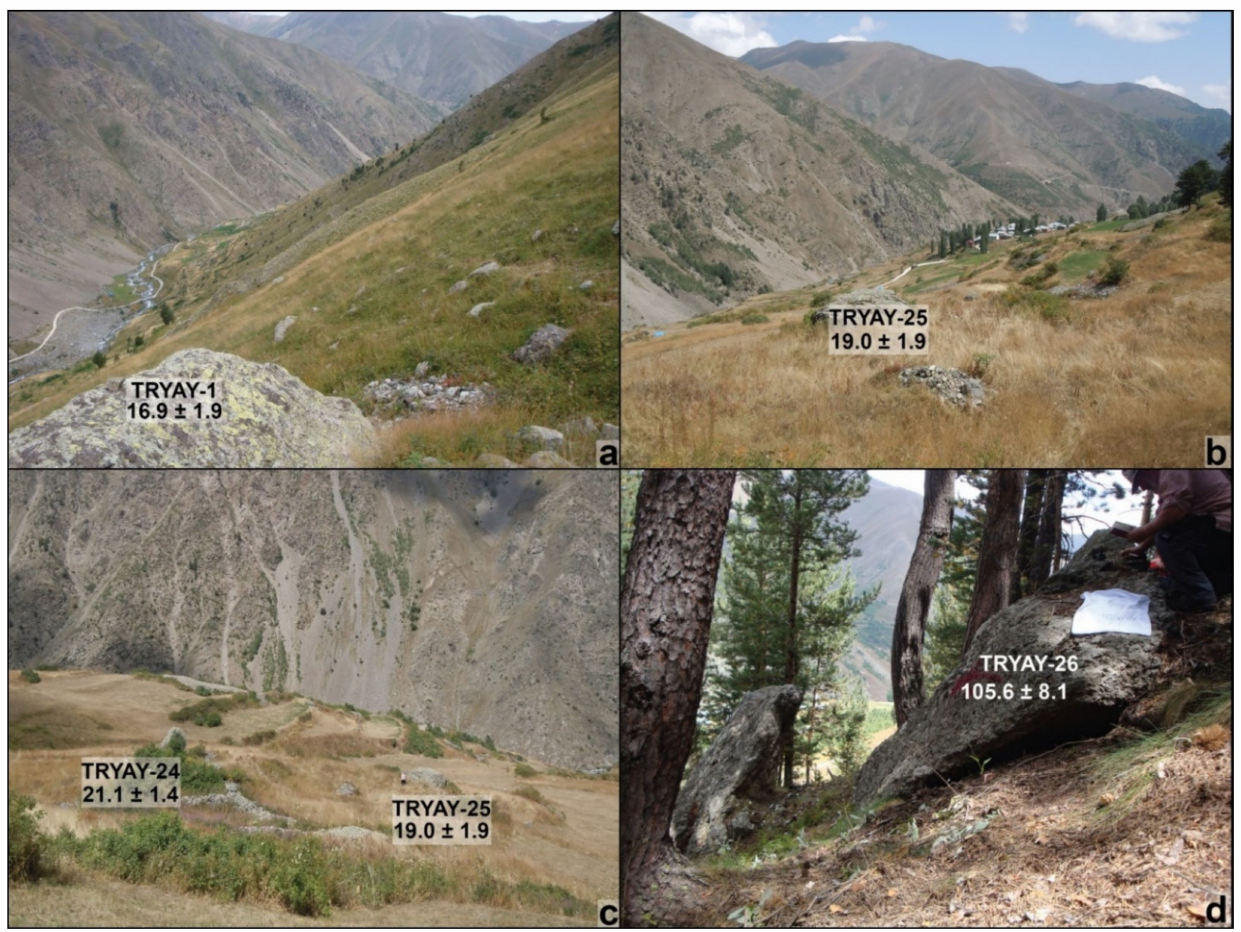
Figure 7. ( a ) Down-valley view from sample station TRYAY-1 at the upper glacier margin. Note the difference in slope morphology with ice contact to the right and superficially decomposing bedrock to the left (see also Figure 7b,c). ( b , c ) Middle part of Barhal Valley with sampled boulders TRYAY-24 (22.2 ± 2.6 ka advance) and TRYAY-25 (18.3 ± 1.7 ka advance). ( d ) Sample TRYAY-26, a decomposing boulder in a steep slope affected by slope